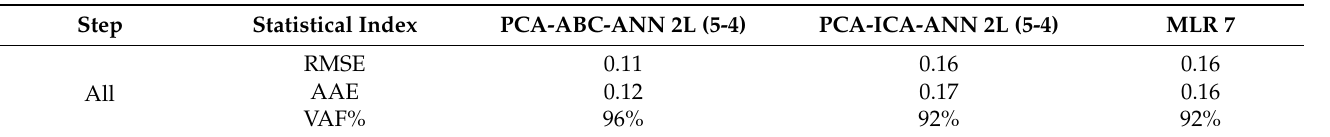
Table 11. Statistical results of bee algorithms, colonial competition, and multiple linear regression model for all samples.